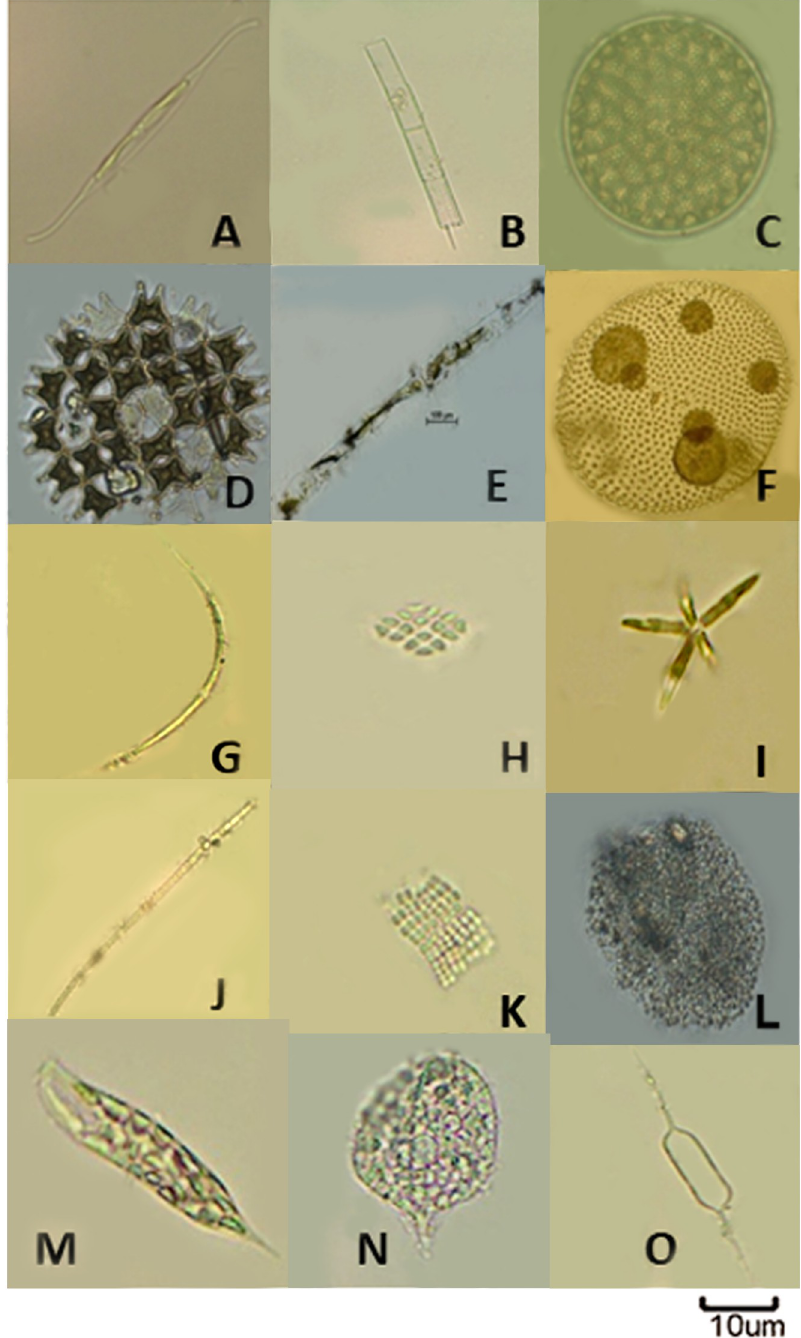
Fig 4. Phytoplankton diversity—Bacillariophyta (A-C); Chlorophyta (D-I); Cyanobacteria (J-L); Euglenophyta (M-N); Ochrophyta (O). Species in details: A . Nitzschiareversa B. Aulacoseiragranulata C. Thalassiosira sp. D. Pediastrum duplex E. Mougeotia sp. F. Volvox sp. G. Closteriopsis sp. H . Crucigenia sp. I. Actinastrum sp. J. Anabaena sp. K. Merismopedia sp. L . Microcystis sp. M. Euglena sp. N. Phacus sp. O. Centritractus sp. 58]. Gopalkrishnan [59] recorded 80 species of plankton in pre-barrage period which was decreased to 58 species during post-barrage period (1985–1991). The mean abundance of